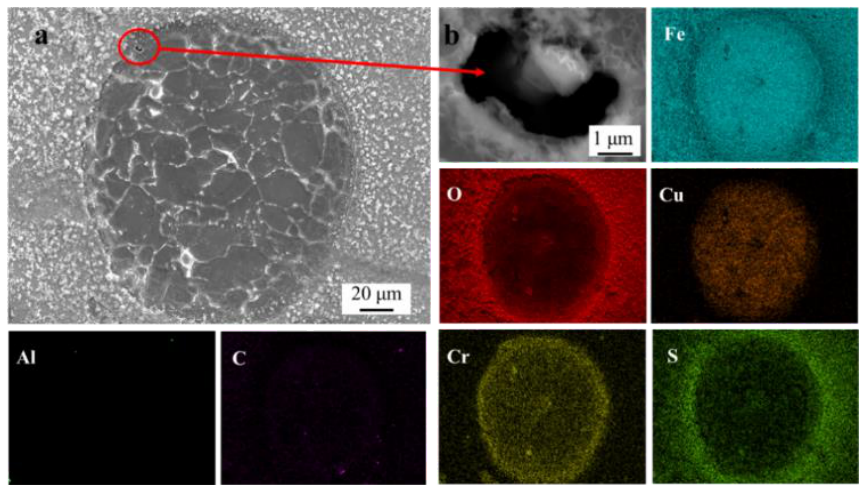
Figure 6. SEM image and EDS maps of the corrosion spot. ( a ) The SEM image of the corrosion spot. ( b ) Pit in the corrosion spot marked in ( a ).